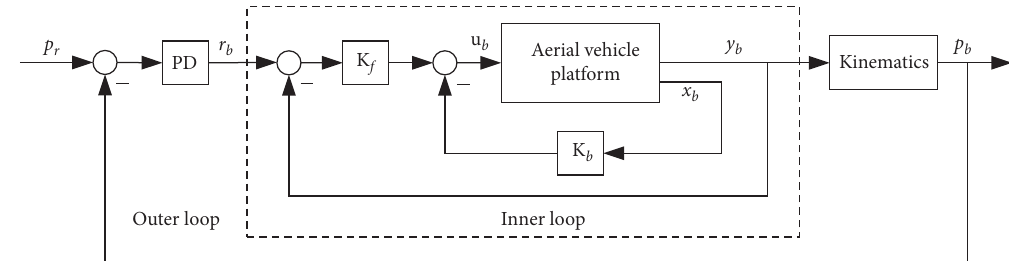
Figure 12: Basic controller architecture.